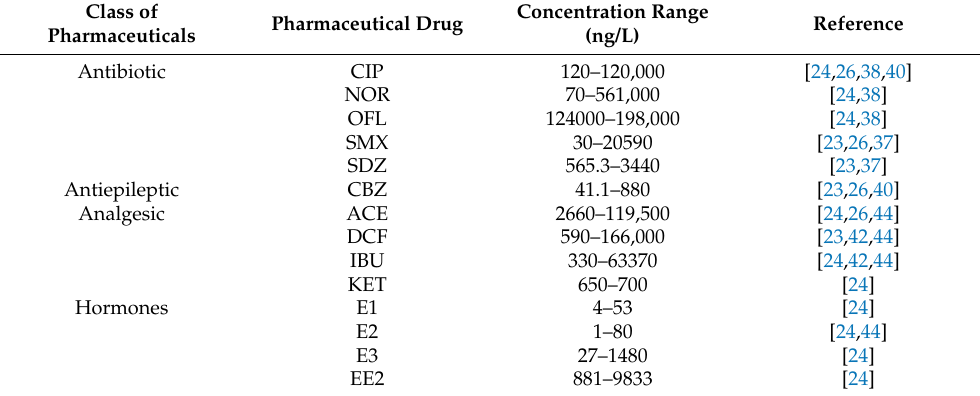
Table 3. Concentration ranges of pharmaceuticals present in the influent of hospital